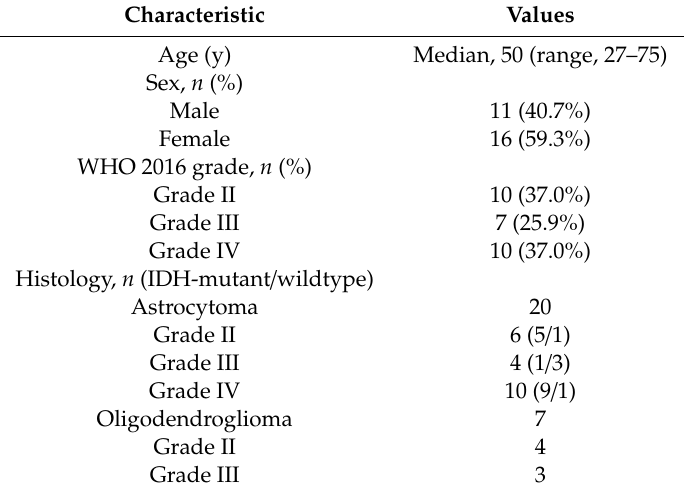
Table 1. Patient Table 1. Patient characteristics.